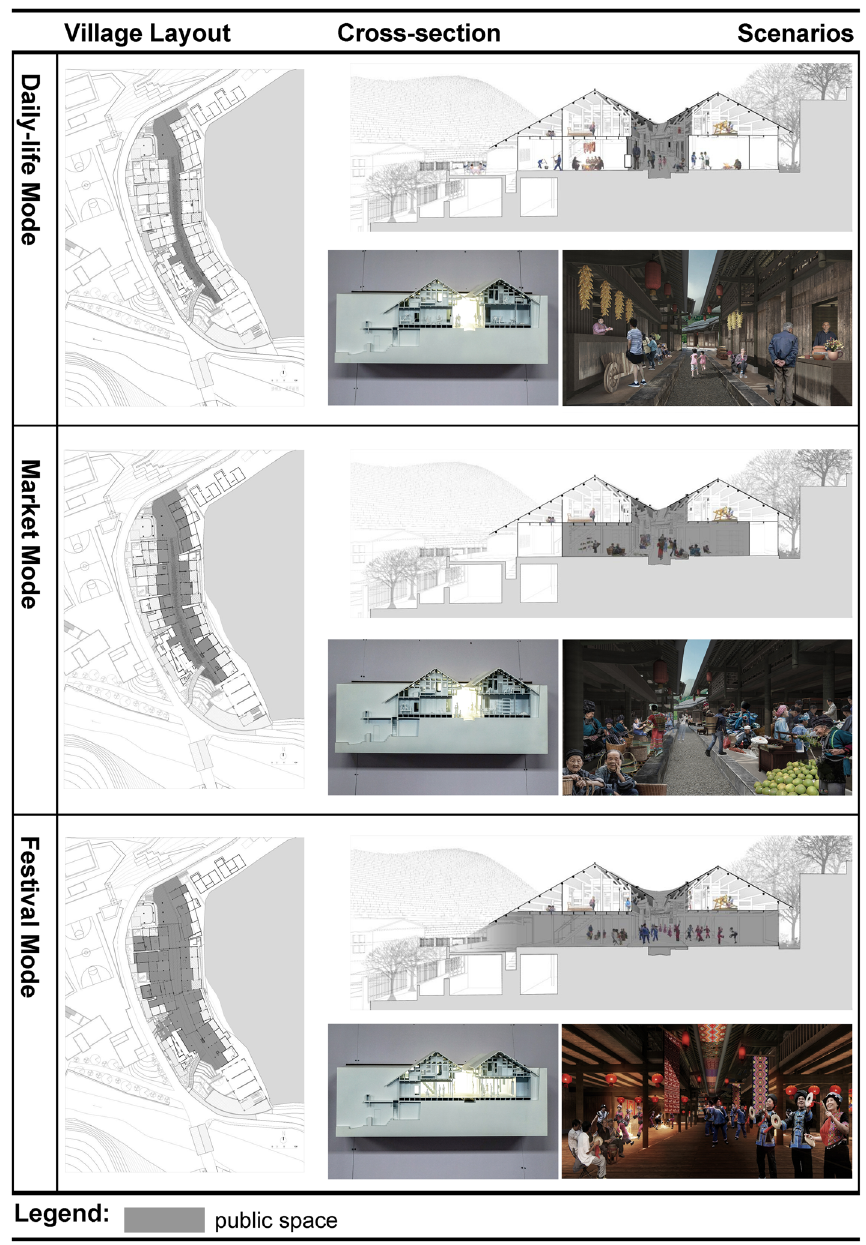
Fig. 3 The experimental design proposal of Lianghekou Village (Source: Zhang, Xu, and Wang 2022)